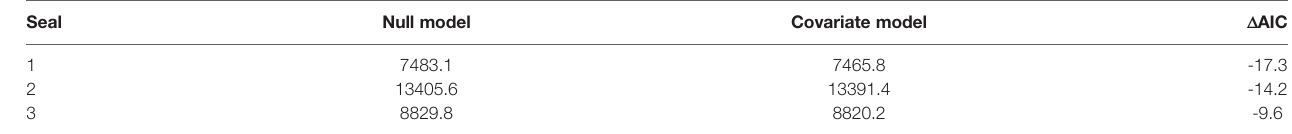
TABLE 2 | AIC values for the null model and covariate model for each seal. Seal